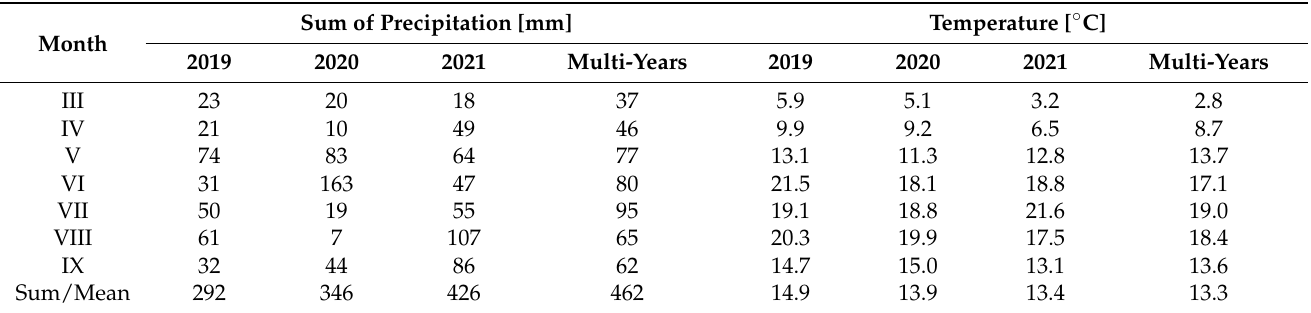
Table 1. Weather conditions (Meteorological Station of the Subcarpathian Agricultural Advisory Center in